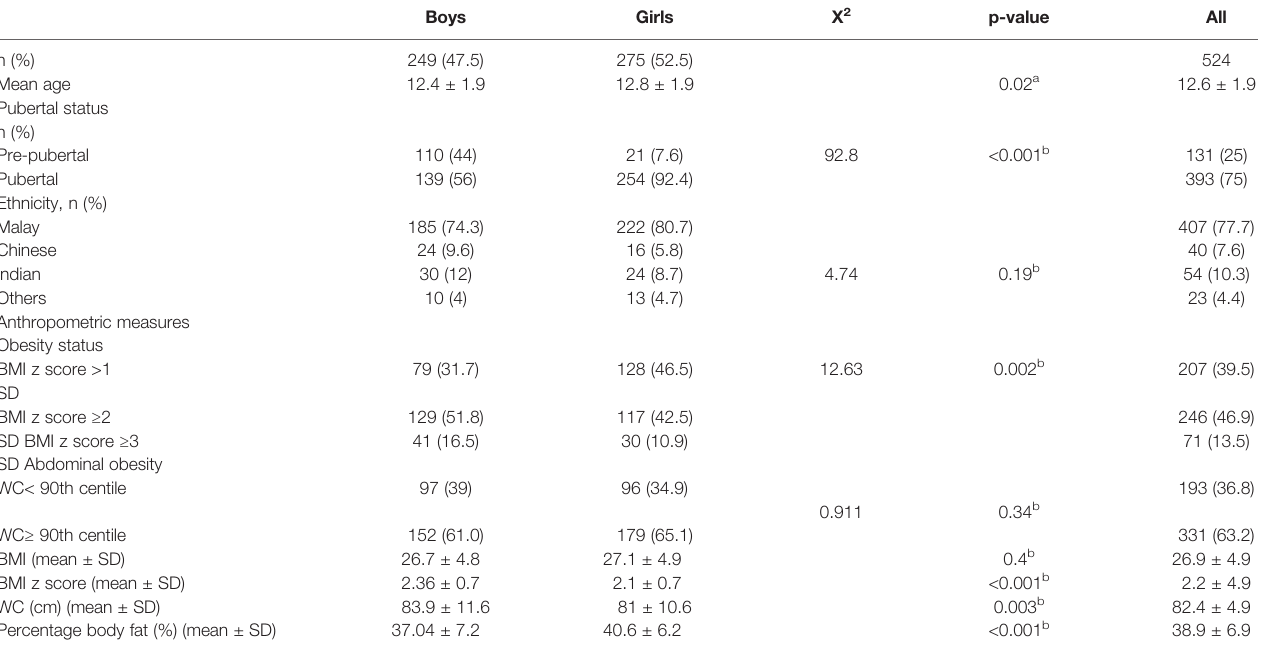
TABLE 1 | Characteristic and anthropometric measures of children with